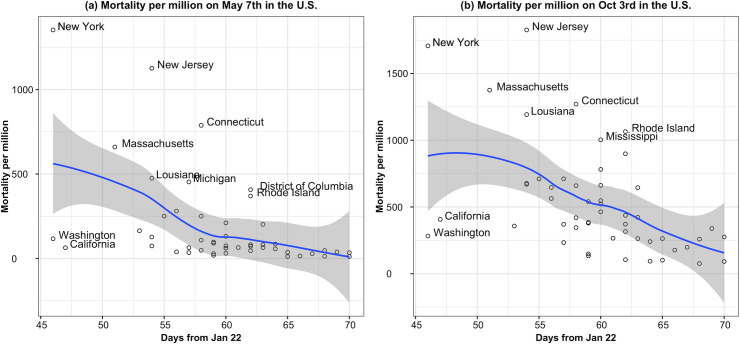
Scatterplot for USA data: Mortality per million versus days from the 22nd of January.